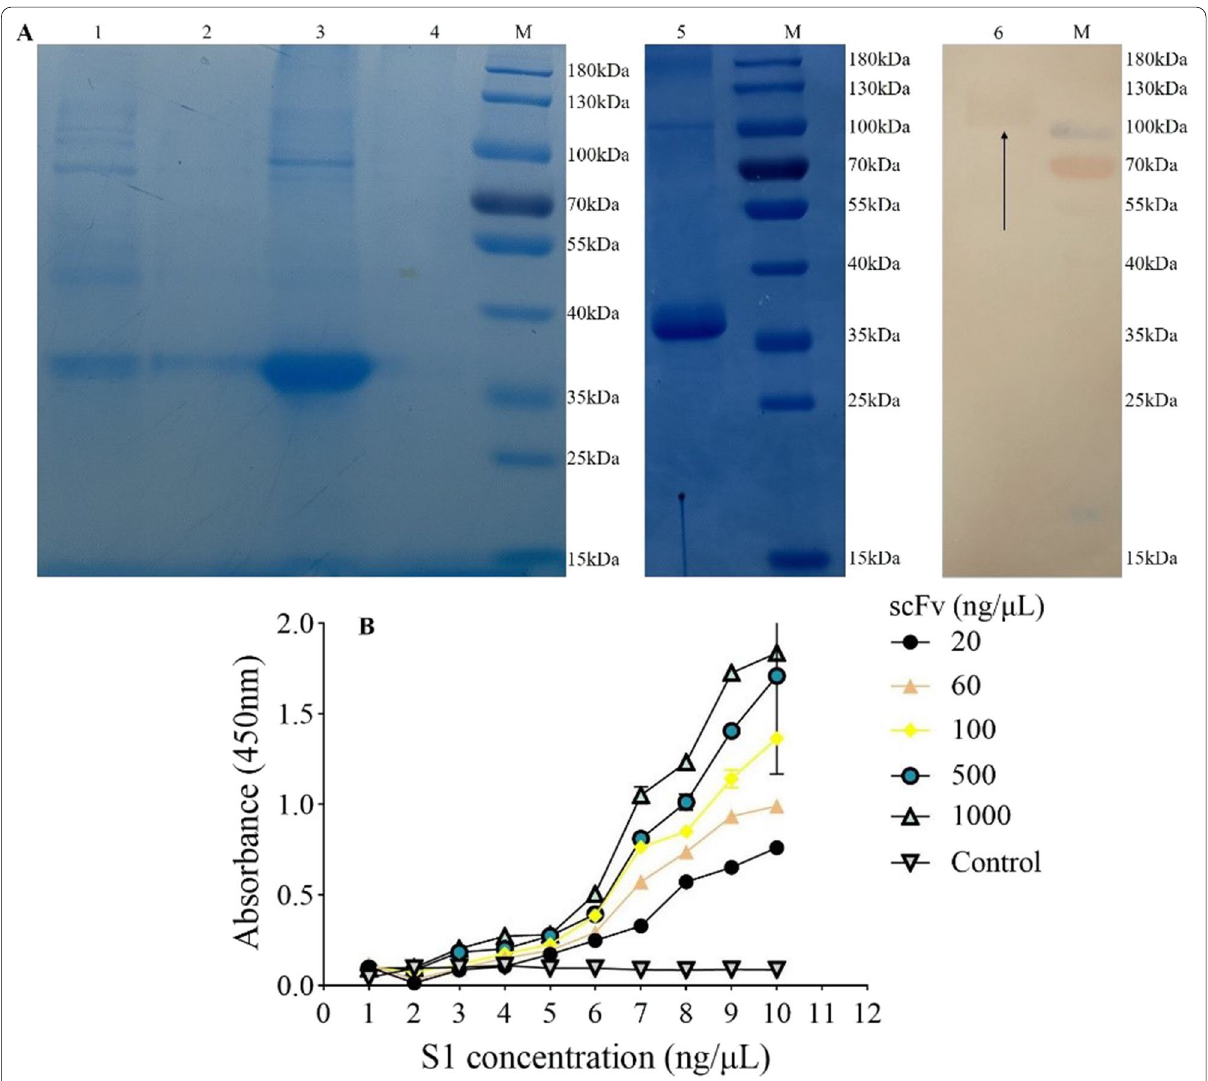
Fig. 7 Characteristics of the IgY-scFv antibody. A ScFv expression, purification and western blot. Lanes 1 and 2: the pET-30a induced and non-induced. Lanes 3 and 4: the inclusion body and supernatant after cell disruption of scFv. Lanes 5: the denatured, renatured and purified scFv protein. Lanes 6: antigen was S1 protein, incubated with primary antibody scFv. M, Pre-stained Protein Ladder. B Analysis of IgY-scFv sensitivity. Control group, PBS; Statistical principle, P/N > 2.0 (P, samples value; N, control value), data of each point represented as Mean